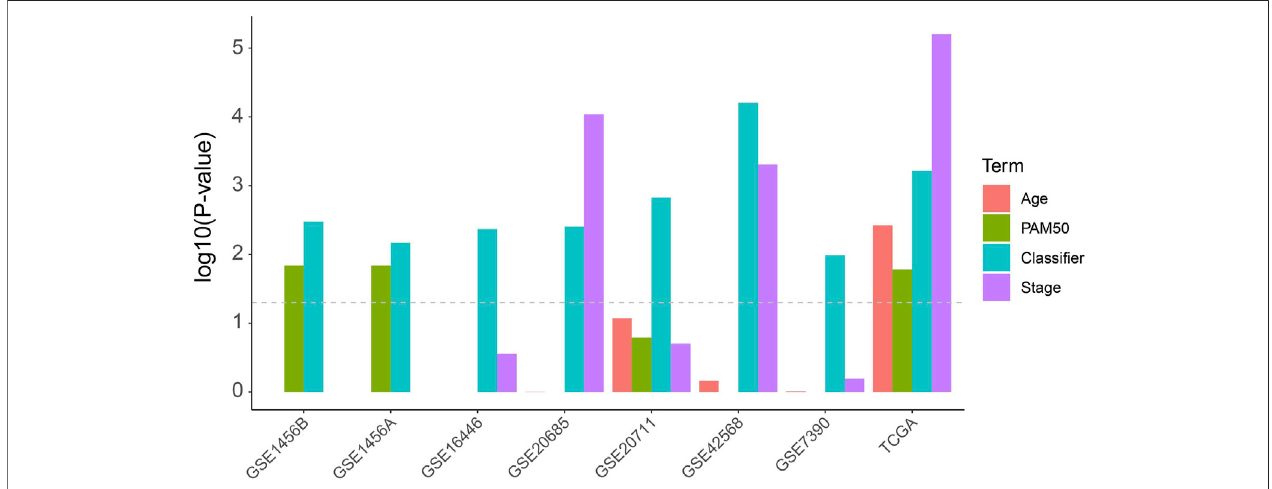
FIGURE 2 | Univariate Cox analysis of the classi fi er as well as regular clinical classi fi cation (Age, PAM50 and tumor stage) in TCGA and other extermal validation cohorts.